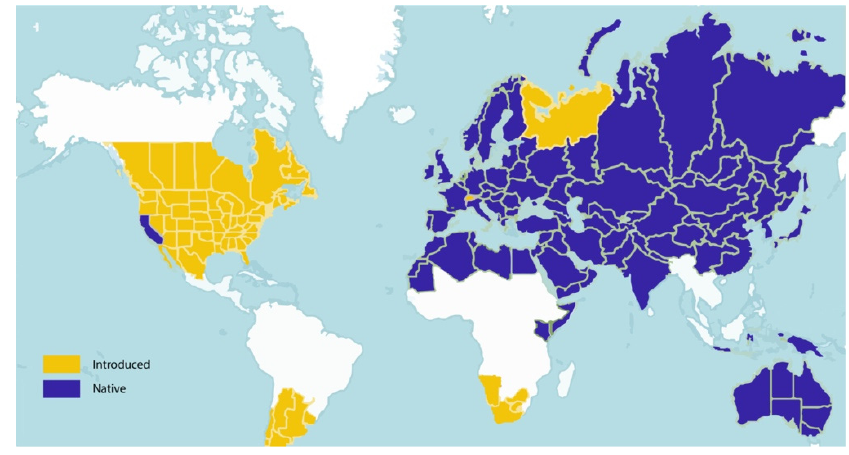
Figure 2. Distribution of genus Salsola in different regions of the world.